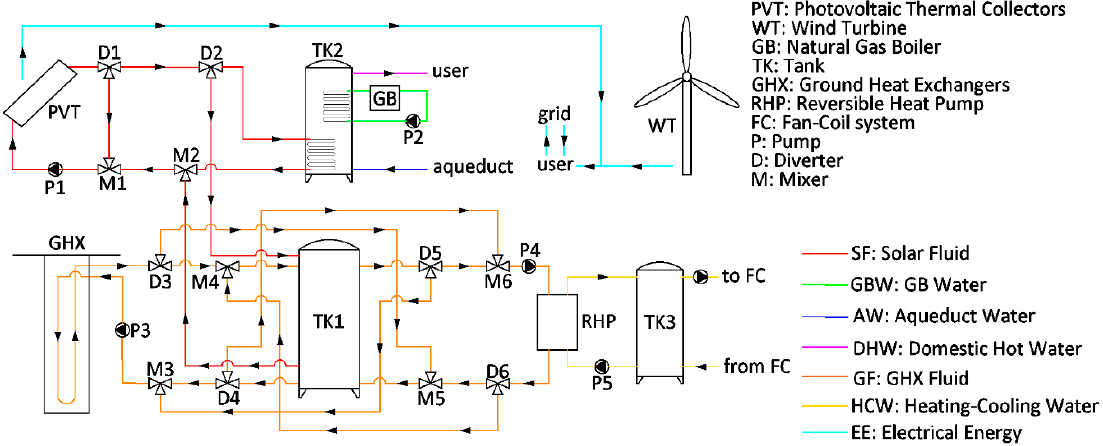
Figure 1. Layout of the system with main loops and components.